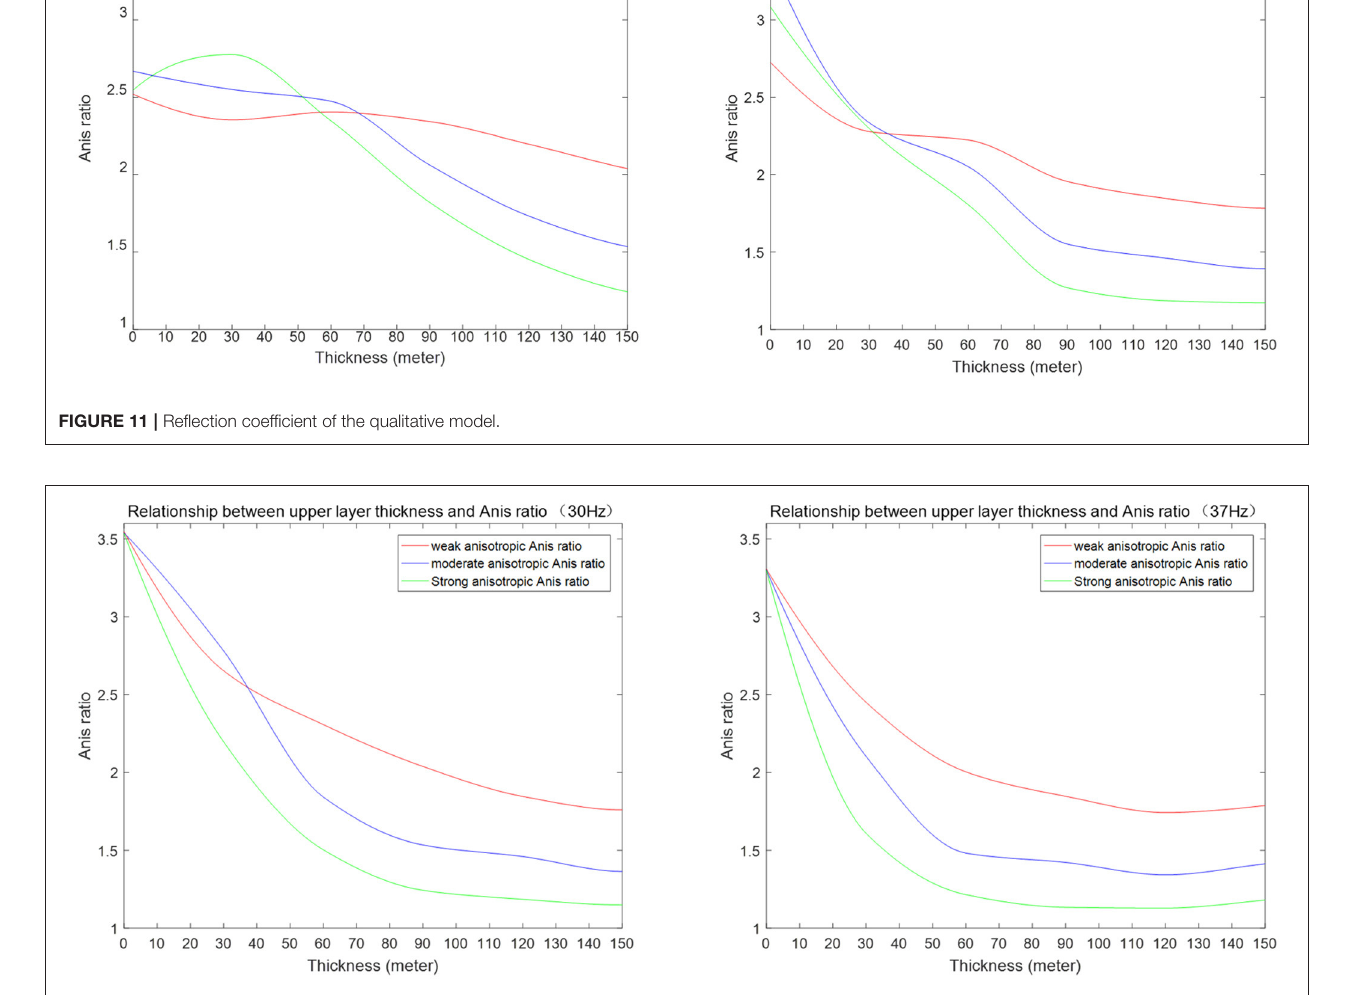
FIGURE 12 | Adjusted model seismic